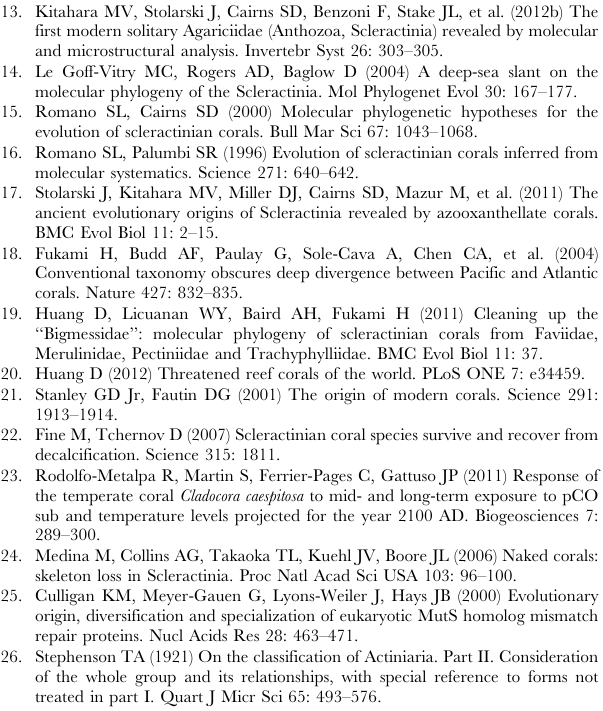
amino acid alignment with the JTT model (C), and for the RNA alignment with the GTR model (D). Table S1 Primer names and sequences used for the amplification/sequence of the mitochondrial genome of Gardineria hawaiiensis . The position and amplicons length of primers designed in the present study or the reference for previously published primers are provided. Table S2 Alignment of the nucleotide sequences from the mitochondrial genes encoding proteins re-coded as purines and pyrimidines (RY-coding see [44,45]